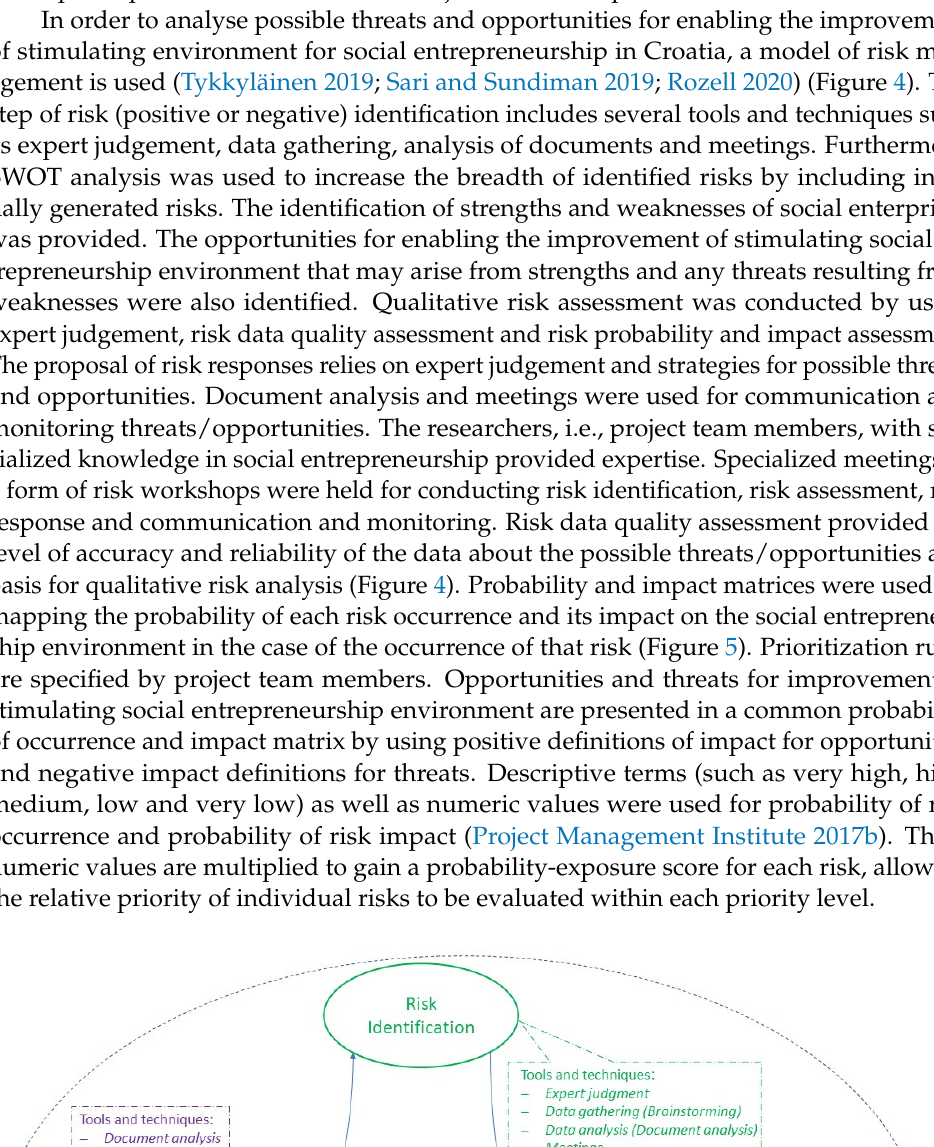
Figure 5. Tool for qualitative risk assessment: probability and impact matrix. Source: Authors., adapted from Project Management Institute (2017b, p. 408). 4. Results 4.1. Results on Legal Forms of Action of Social Enterprises in Croatia The profit sector includes legal forms (companies and crafts) that meet the criteria of operational definition of social entrepreneurship adopted by the EU (economic/entrepre ‐ neurial, social and ownership dimension). Each of these forms has its advantages and dis ‐ advantages. Which of them will be chosen depends on several criteria, namely the circum ‐ stances of the particular case, the size of the undertaking, the financial means available and the content of the activities performed (Operational Program: Effective Human Re ‐ sources 2014). The legal forms of action of social enterprises in the Republic of Croatia (Figure 6) are as follows:  Companies: a limited liability company and a joint stock company;